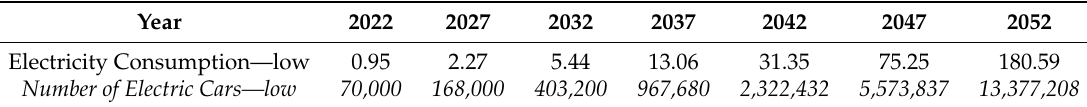
Table 2. BASE scenario electric cars’ lower electricity consumption bounds (PJ).